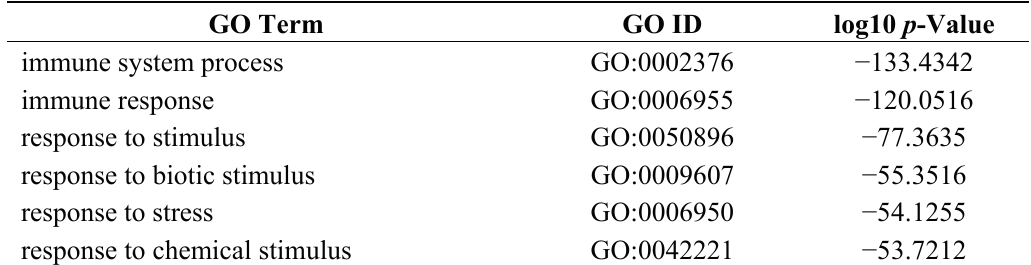
Table 3. Twenty most enriched GO terms in the carotid